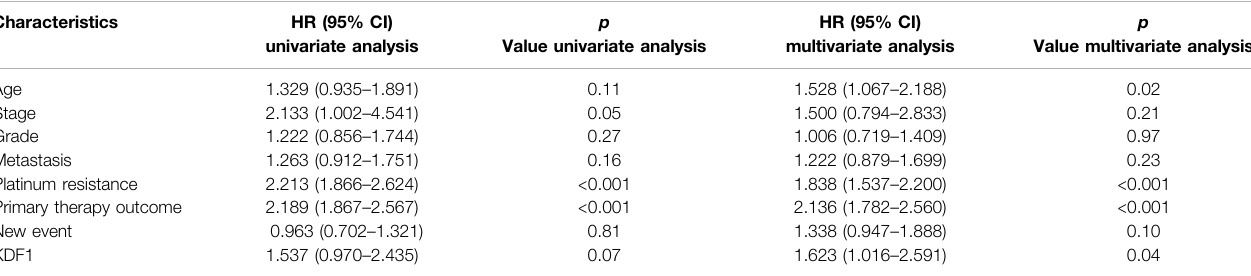
TABLE 3 | Univariate and multivariate analyses of clinicopathologic parameters in patients with ovarian cancer in TCGA-OV.